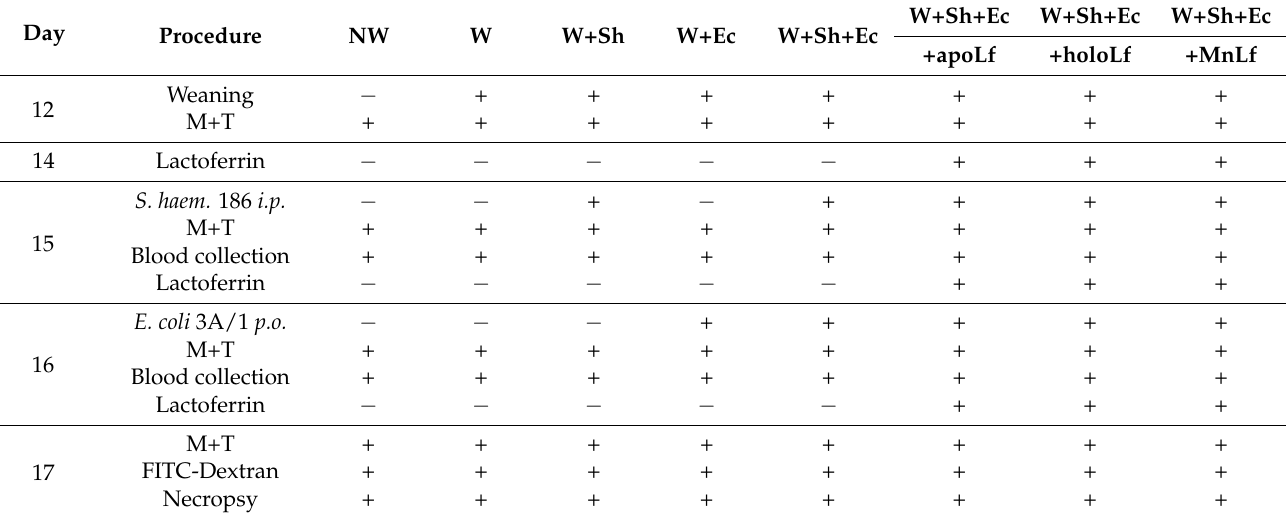
Table 1. Procedures performed on animals in individual study groups during the